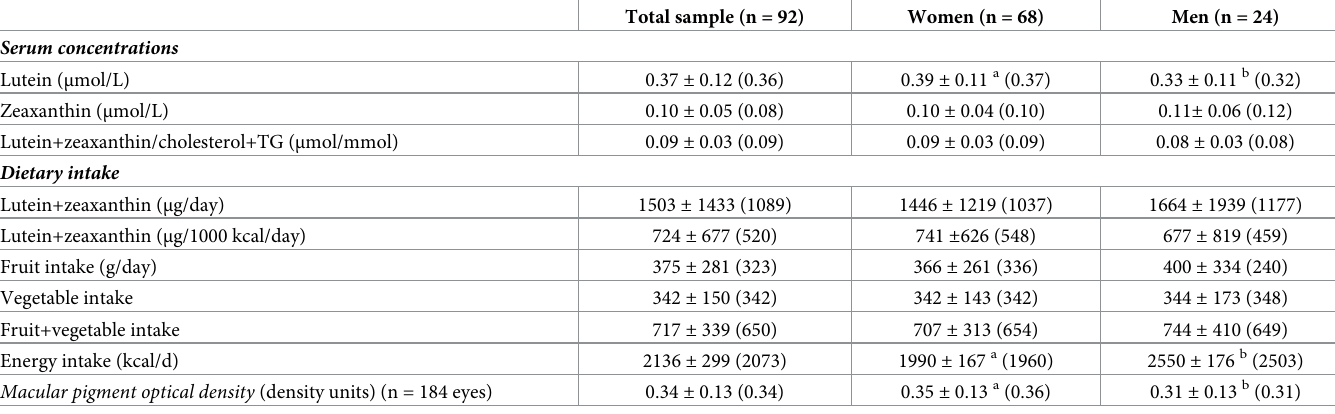
Table 2. Serum concentrations and dietary intake of lutein and zeaxanthin and, MPOD [mean ± standard deviation and